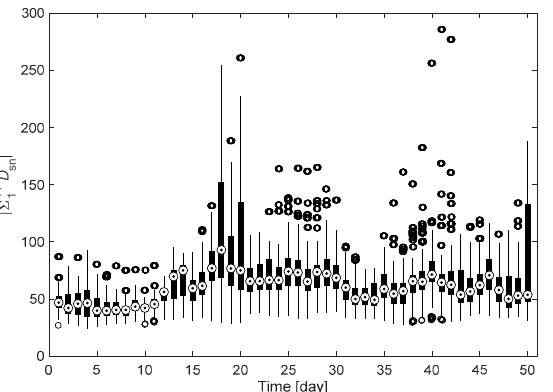
Figure 10. Box plots of the classification potential ( D sn values) when using the 115 feature prototypes with 715 different variable combinations at each starting day in time windows of 14 days. The highest individual D sn values are plotted with ‘o’ markers.